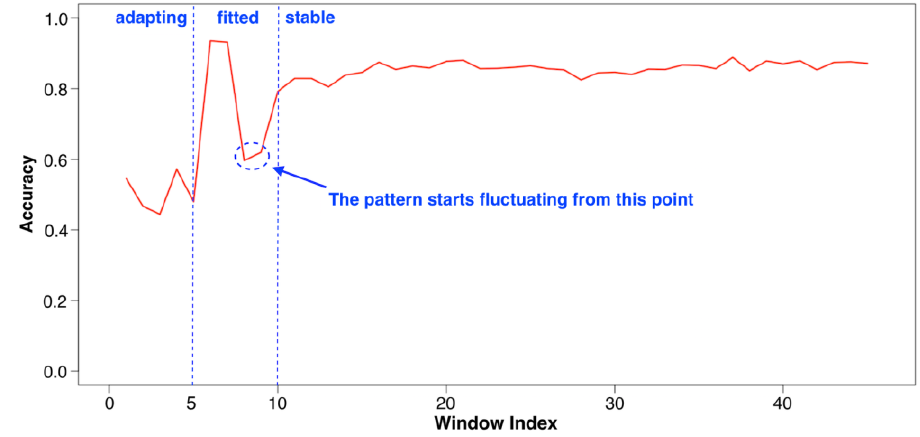
Figure 9. Trajectory of the accuracy.